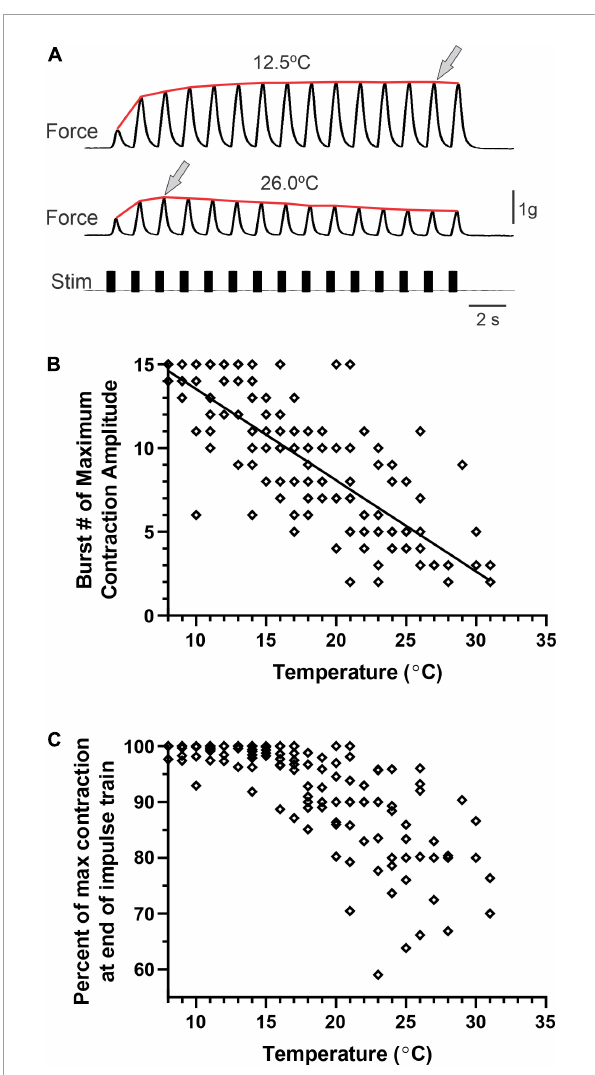
FIGURE7 Cardiac muscle contractions persist at high temperatures, although facilitation is altered by temperature. (A) Example recordings of evoked muscle contractions at 12.5 ◦ C (top trace) and 26 ◦ C (middle trace) in response to exogenous nerve stimulation (lower trace). Arrows indicate the contraction of maximum amplitude in each recording. The red line shows the envelope of the contractions at each temperature. Both recordings are from the same preparation. (B) Plot of the burst number at which evoked contractions reach maximum amplitude for a train of stimulated contractions at each temperature (1.5 ◦ C increments) between 8 ◦ C and 31 ◦ C. Note that the contraction at which maximum amplitude is reached within the train of stimuli decreases with increased temperature ( R 2 = 0.63, p < 0.001). (C) Contractions showed more defacilitation over the train of contractions at higher temperatures. Plot of the percentage of the maximum contraction amplitude that remained at the end of the train of stimuli [i.e., 100*(Amplitude last contraction/amplitude max contraction)]; N = 9.